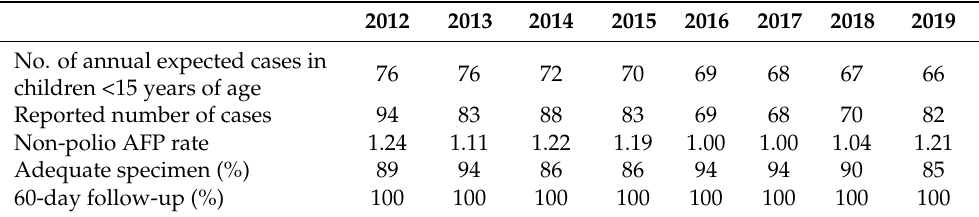
Table 1. Classification of AFP patient surveillance indicators in Korea, 2012–2019.